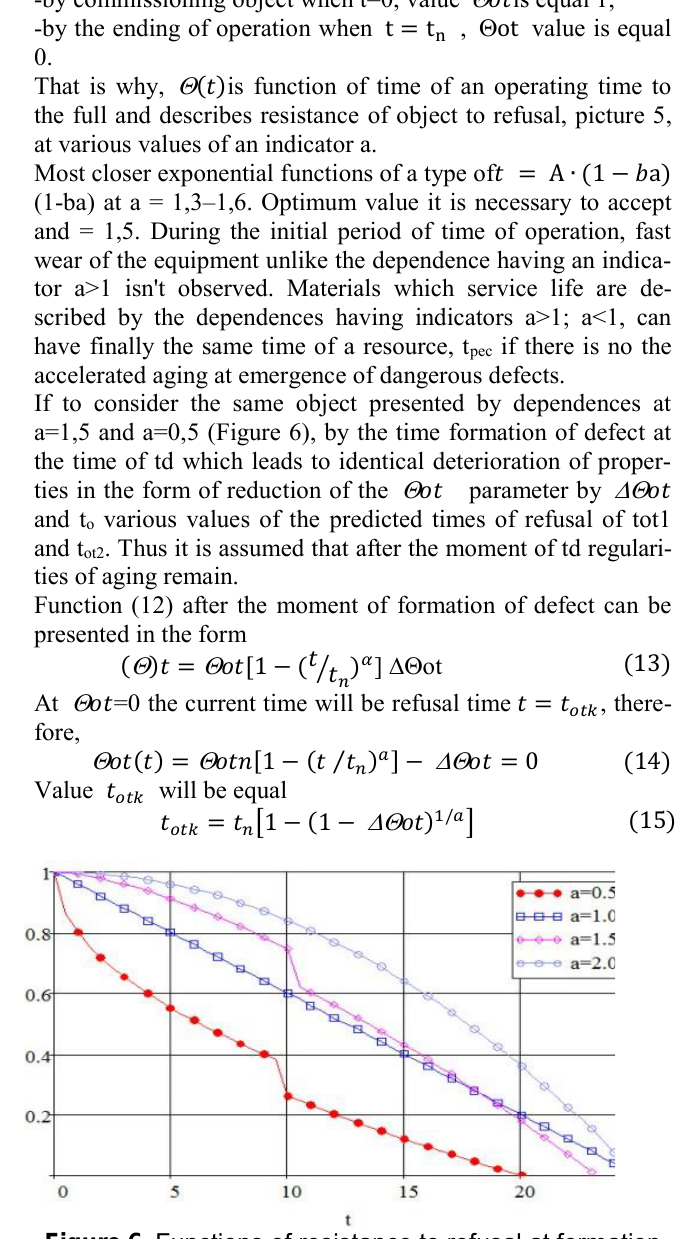
Figure 6 . Functions of resistance to refusal at formation of defect and a residual resource